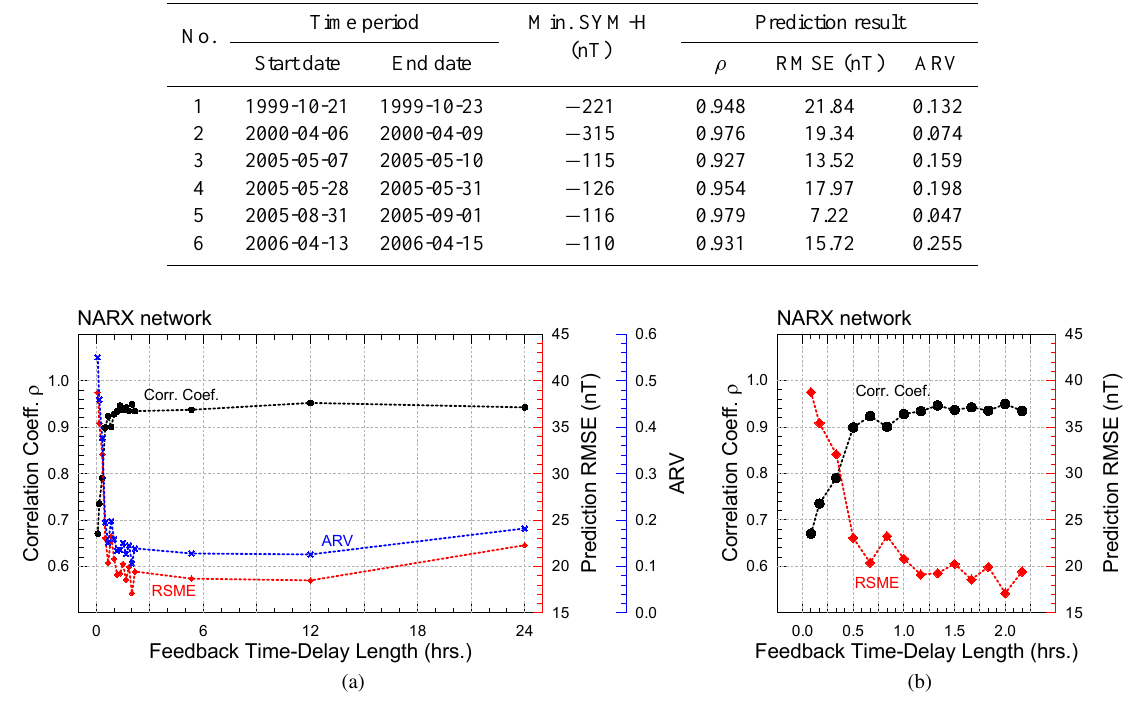
Fig. 5. Prediction performance by NARX network versus feedback delay time length of L . (a) For L value from 0 to 24 hours; (b) A zoom-in view of (a) for L value from 5 to 130 minutes.